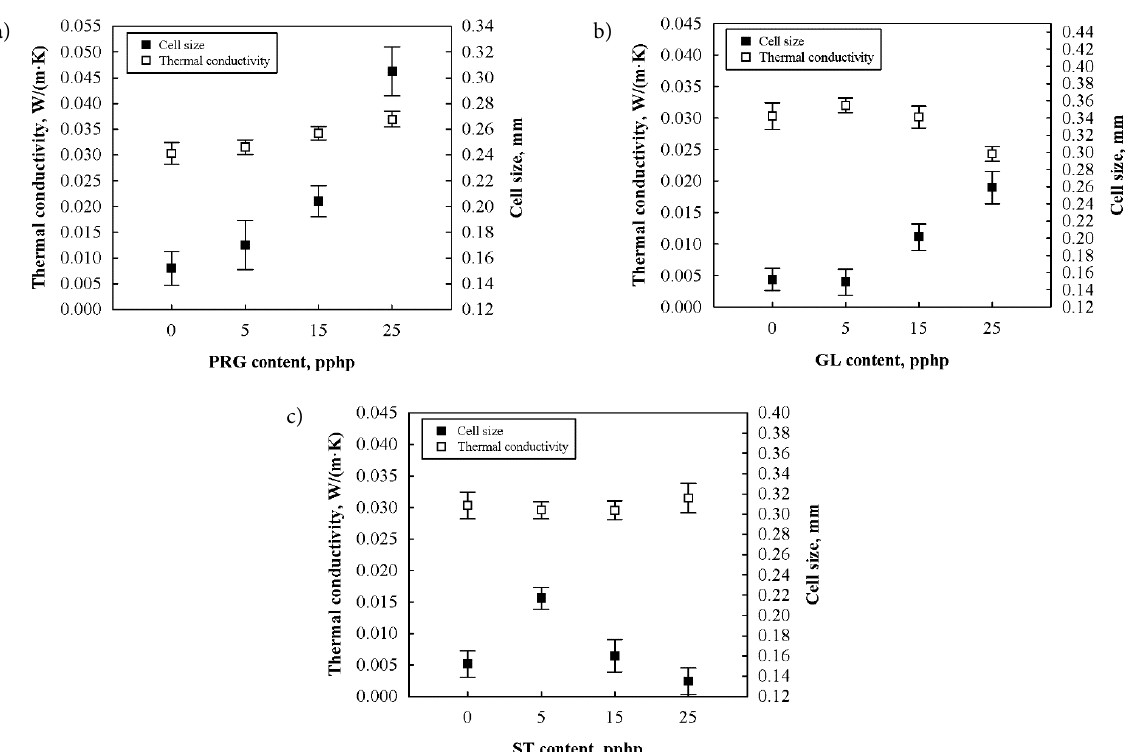
Fig. 1. Thermal conductivity and cell size of a) PU/PRG; b) PU/GL; c)